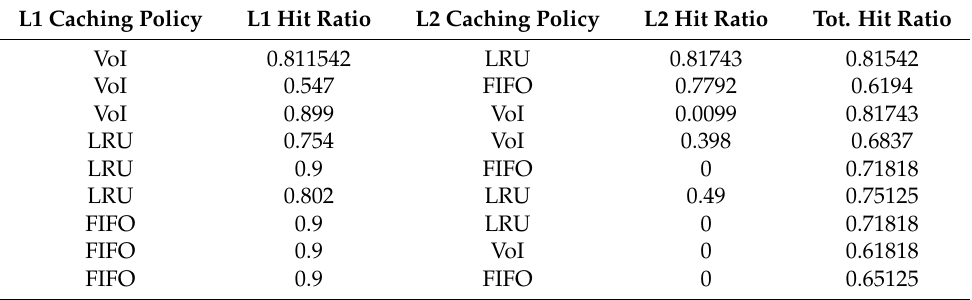
Table 2. Two-level caching comparison.